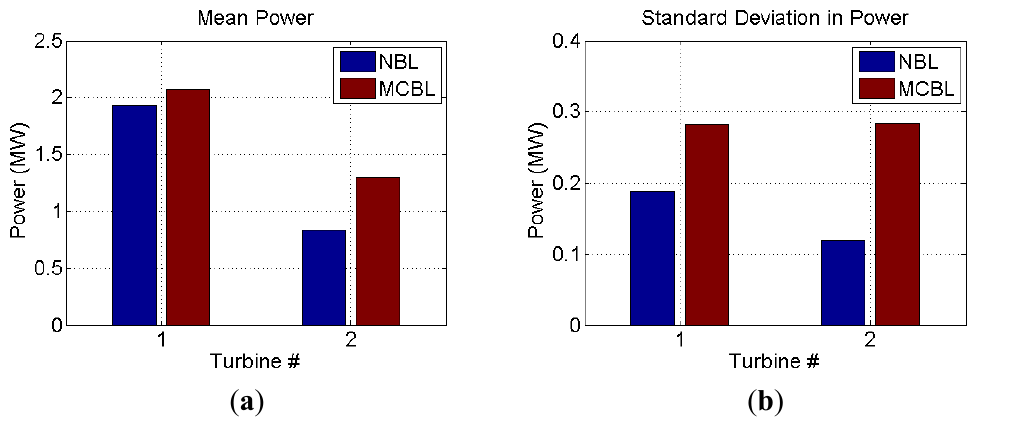
Figure 9. Mean and standard deviation of power (Turbine-Turbine Interaction Problem, V Wind = 8 m/s). ( a ) Mean; ( b ) Std.